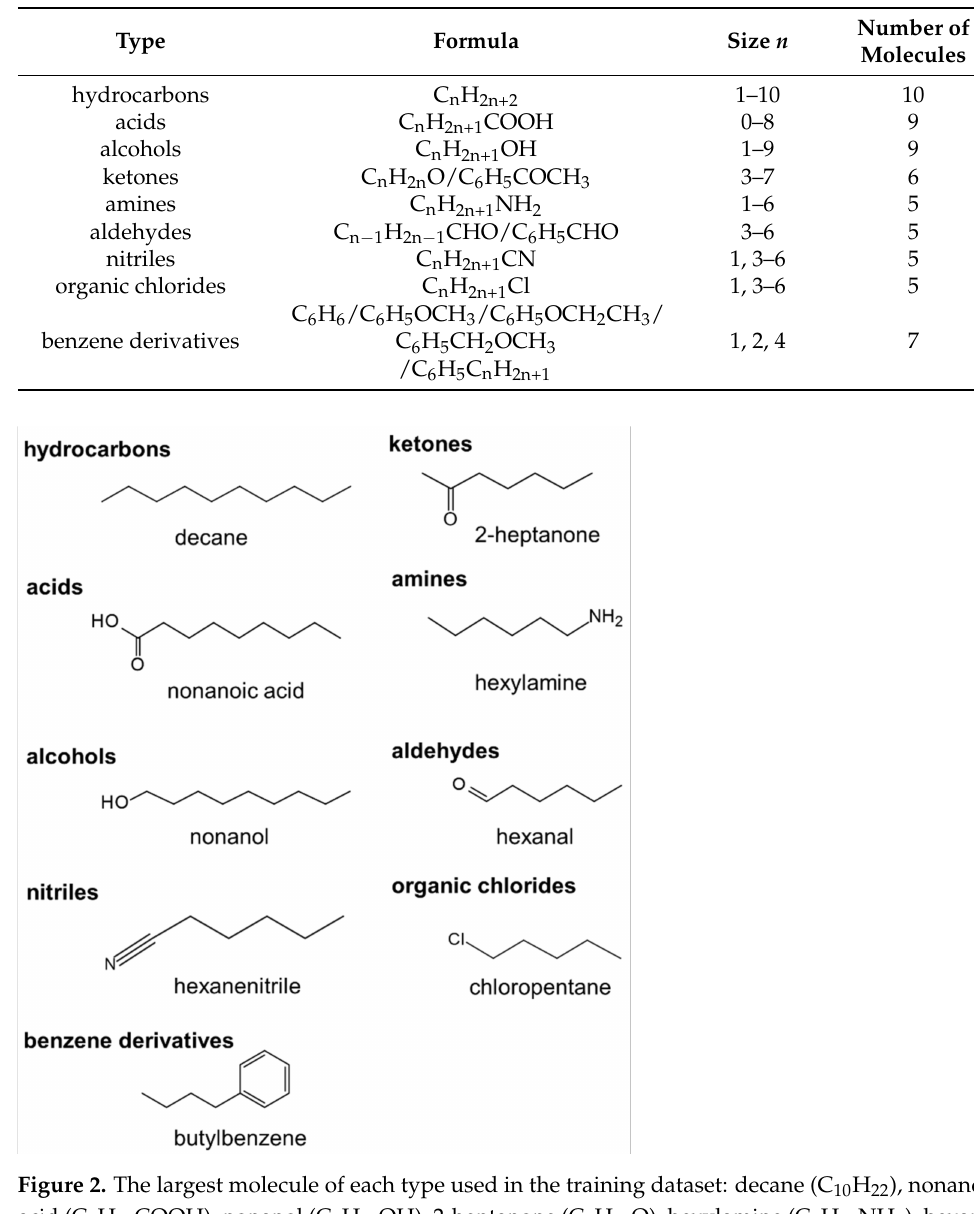
Table 1. Summary of the molecules included in the training dataset with experimental ∆ H vap (see Supplementary Materials, Tables S1 and S6).